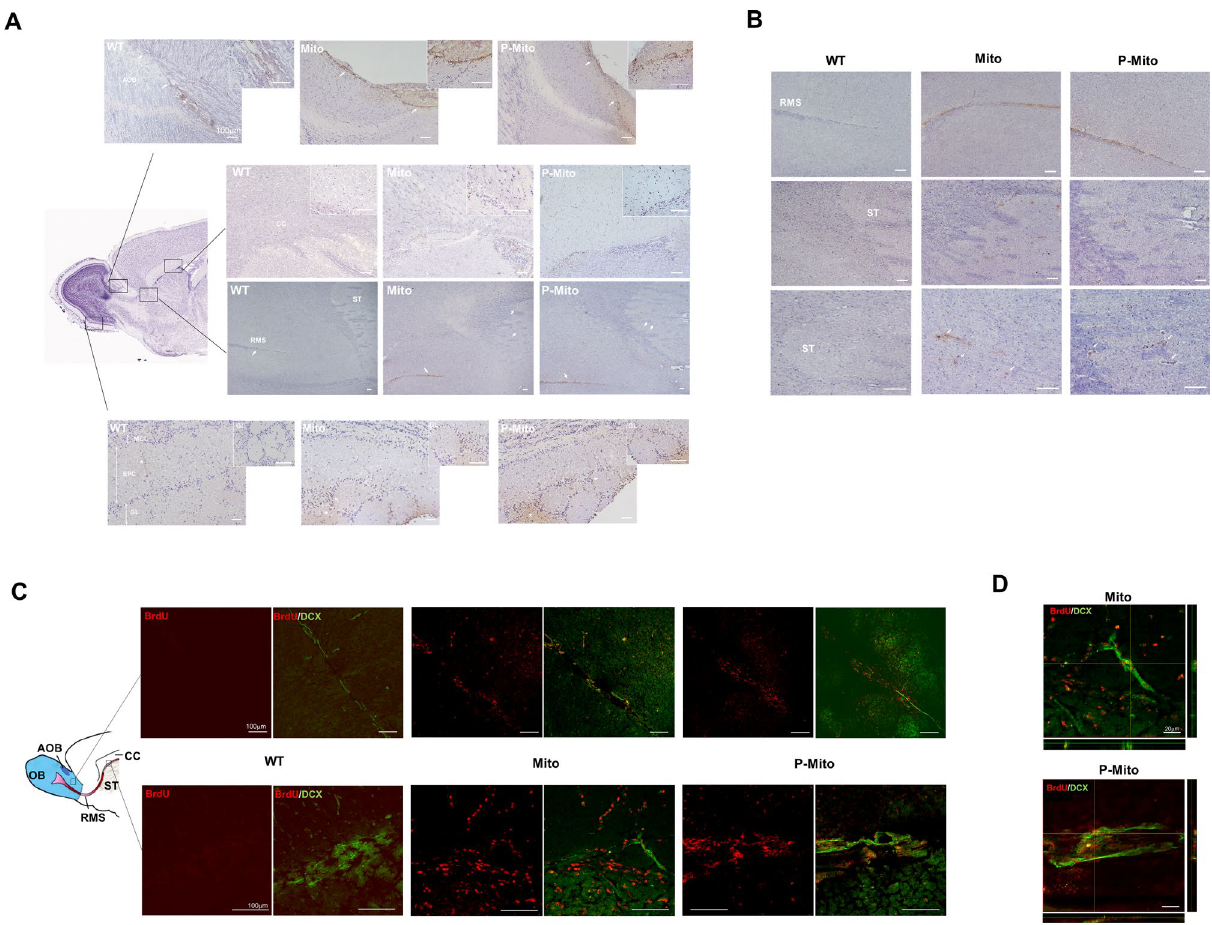
Figure 6. Representative photomicrographs showing distribution and delivery of intranasally administered mitochondria labeled with bromodeoxyuridine (BrdU) via the rostral migratory stream (RMS). ( A ) Anti-BrdU antibody followed with horseradish peroxidase allowed tracking of allogeneic mitochondria (brown color) in different brain regions of the olfactory bulb glomerular layer (GL), accessory olfactory lobe (AOB), corpus callosum (CC) and striatum (ST), represented as rectangular high-power fields in the sagittal sections of mouse brains. Nuclei were counterstained with Meyers’s hematoxylin (blue dots). Arrows indicate BrdU-positive signals in high-magnification fields. BrdU-labelled mitochondria are obvious in the ST (third panel) and CC in zoomed images (second panel). Intranasally administered mitochondria penetrated to the AOB (first panel), but not to the bulb glomerular layer (GL) of the outer tissue layer of the olfactory bulb (fourth panel), and progressed into the RMS (third panel). ( B ) Expression of BrdU signals in the RMS and ST at higher magnification. ( C ) Double immuofluorescent staining with doublecortin (DCX) and BrdU antibodies confirmed the uptake of exogenous mitochondria (red color) in DCX-positive migrating neurons of the RMS (green color) around the AOB / ST-CC interface, indicated with a rectangle. (D) Co-localization of images was captured in double-labeled sections in single optical sections of z-stack confocal images, presented as side views of the x–z and y–z planes. * P < 0.05, vs. Sham, WT wild-type controls, Mito mitochondrial alone, P-Mito Pep-1-labelled mitochondria, OB olfactory lobe, EPC external plexiform cells, MCL mitral